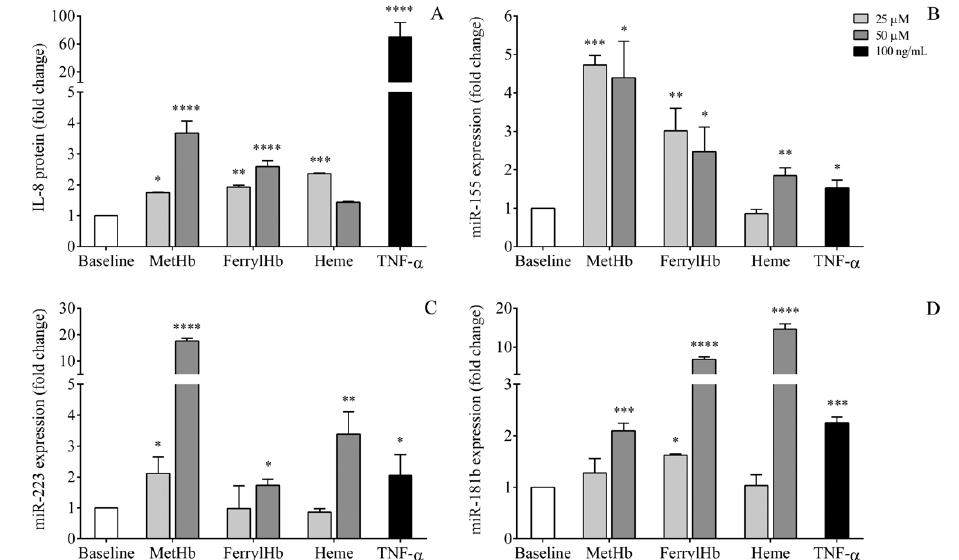
Figure 7. Human choroid plexus epithelial cells were treated with metHb, ferrylHb, heme (25 or 50 µ M, light and dark gray columns, respectively), and recombinant TNF- α (100 ng / mL, black column) for 24 h ( n = 3 / group) to generate cellular inflammatory conditions in an in vitro model of IVH-induced inflammation. In response to metHb, ferrylHb, or heme, significantly elevated IL-8 protein levels were detected already at lower concentrations compared to untreated sample (white bar) as seen after treatment with TNF- α ( A ). In addition, extracellular miRNAs showed a substantial upregulation in the cell culture supernatant of the cells ( B – D ). Mean ± SEM are depicted. * p < 0.05, ** p < 0.01, *** p < 0.001, **** p < 0.0001 vs. baseline based on ANOVA with Bonferroni’s multiple comparisons